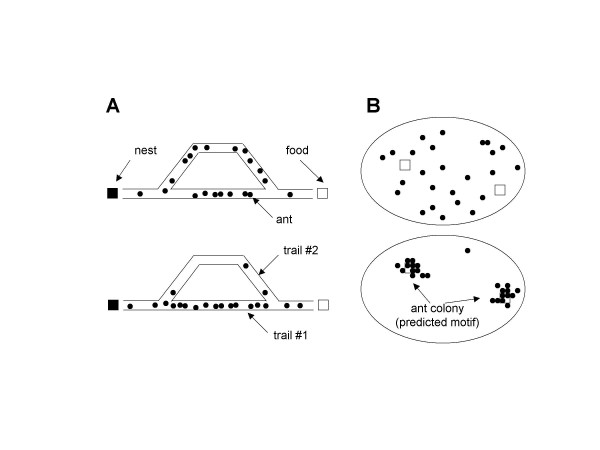
Schematic illustration of the ant algorithm. (A) Selection of a shorter path between a nest and a food source by natural ants. The ants travel between the nest and food through trail #1 and trail #2. Initially, ants are distributed equally on both trails (top). Since trail #1 is shorter than trail #2, trail #1 becomes their favorite pathway with a higher pheromone concentration (bottom). (B) Modeling gene expression using artificial ants. In an artificial nucleus consisting of two transcription-factor binding motifs involved in the regulatory model, ants are initially located in a random fashion (top). These two motifs are treated like a food source, and two ant colonies are formed after cycles of pheromone deposition and evaporation (bottom).